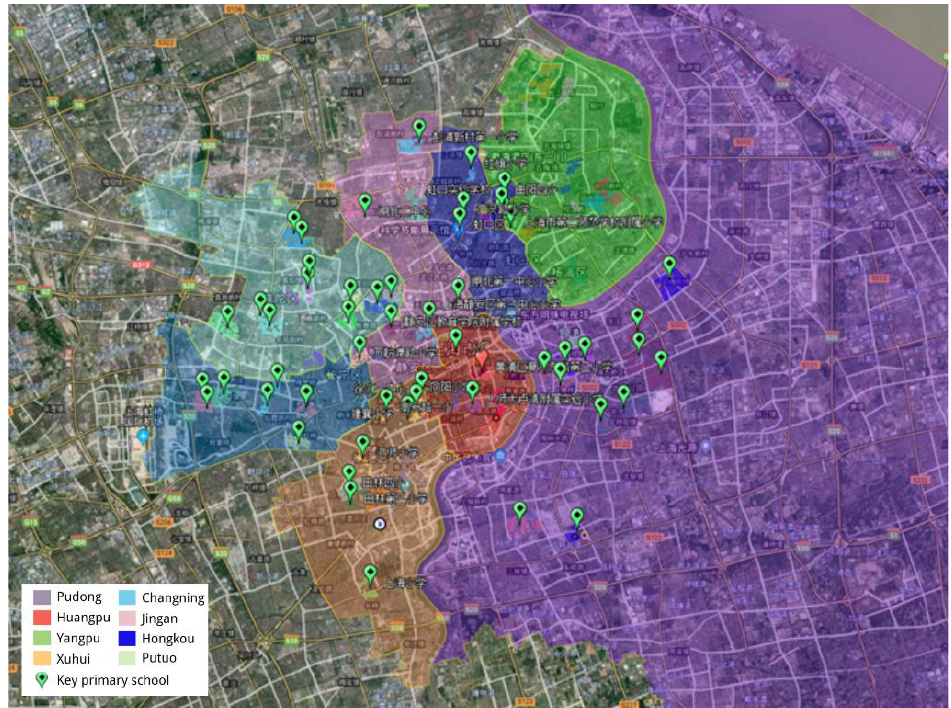
Figure 1. The location of selected key primary schools in Shanghai.